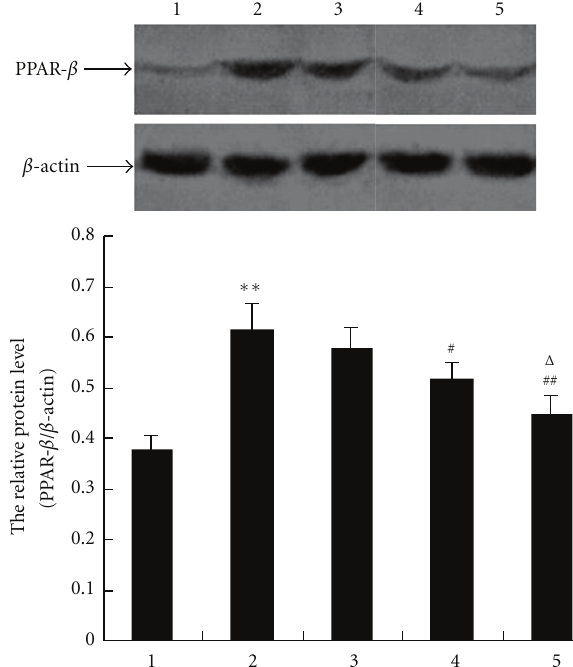
Figure 3: GW0742 inhibits the GCIRI-induced increase of mRNA expression of PPAR- β in hippocampus of rats ( n = 4). The relative mRNA level of PPAR- β was normalized to endogenous β -actin mRNA for each sample. M: DNA marker, 1: vehicle sham group, 2: vehicle model group, 3: GW0742 20 model group, 4: GW0742 60 model group, and 5: GW0742 180 model group. Dates are expressed as mean ± SD of four individual experiments. ∗∗ P < 0 . 01 compared with vehicle sham group; # P < 0 . 05, ## P < 0 . 01 compared with vehicle model group; Δ P < 0 . 05 compared with GW0742 20 model group.